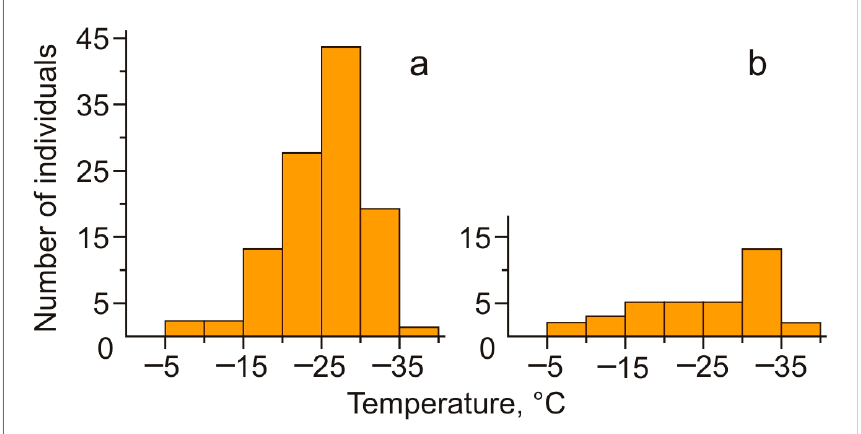
Figure 3. Distribution of the supercooling point values ( SCP ) of the Aglais urticae in samples from ( a ) the environs of Magadan (2018, 2020 and 2022) and ( b ) Seymchan (2022). When determining the lethal temperatures, it was found that 50% mortality (LT 50% ) in the Magadan sample occurs between − 20 and − 25 °C; at − 28 °C, 33% of individuals survived, and at − 30 °C, 10% of individuals survived (4 out of 40 cooled); all individuals died at − 35 °C. In the sample of butterflies from Seymchan, after exposure at − 28 °C ( n = 24), 70% of individuals were alive; all butterflies of the sample ( n = 20) cooled to − 35 °C died. 3.4. The Natural Temperature Conditions of Wintering The natural temperature conditions of wintering of the populations from which the cold hardiness of the small tortoiseshell was determined greatly differ (Table 4). The av- erage January temperatures in London are higher than those in Magadan by almost 22 °C, and they are higher than in Seymchan by 43 °C (and the average of the absolute minimums—by 57 °C!). Table 4. Air temperature in geographical locations where the cold hardiness of Aglais urticae was studied. Location Altitude, m Table 3. Supercooling point ( SCP , in ° С ) of imago Aglais urticae in different years in three popula- tions. Population